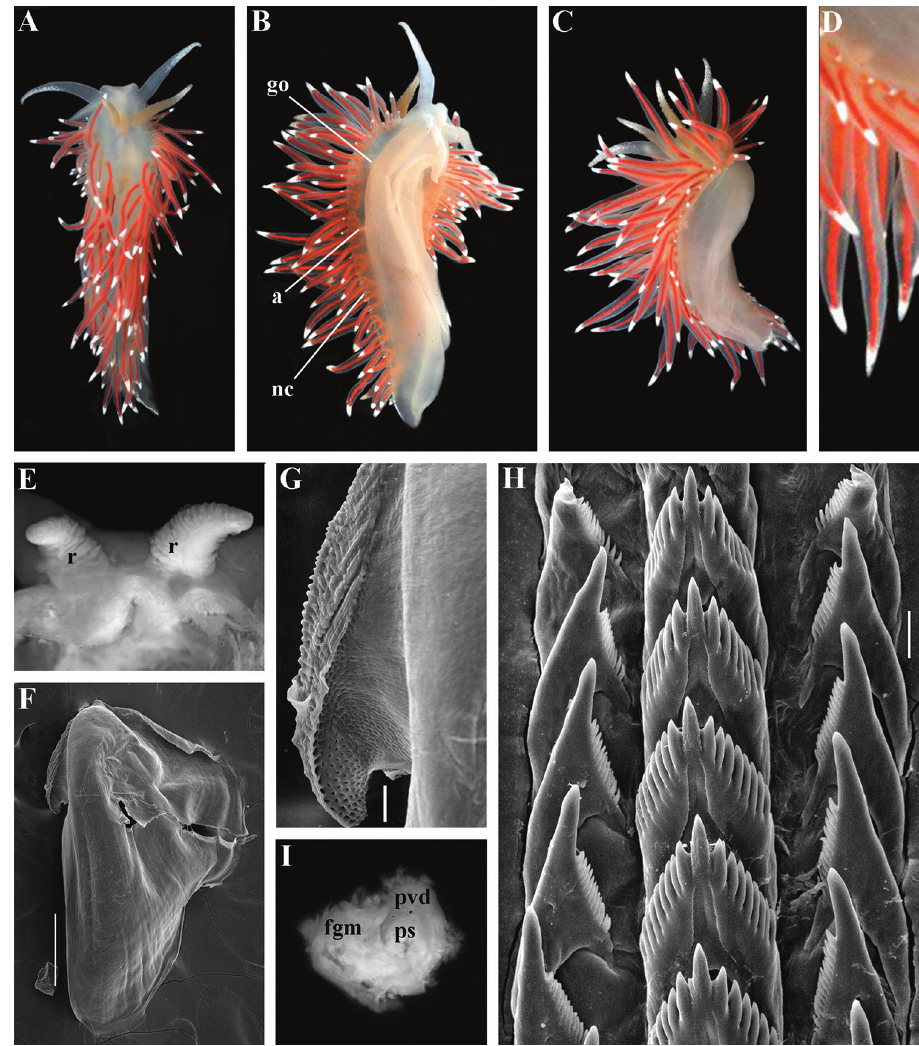
Figure 16. Borealia nobilis (Verrill, 1880), comb. n. ZMMU Op-510. White Sea, Cape Kartesh, 33 mm in length (live): A living animal, dorsal view B same, ventral view C same, lateral view D same, details of cerata E dissected anterior part (pharynx removed) and rhinophores, light microscopy F jaw, SEM G details of masticatory process of jaw, SEM H radular teeth, posterior part, SEM I reproductive system (non mature), light microscopy. Abbreviations: a anus fgm female gland mass go genital opening nc con- tinuous notal edge ps penial sheath pvd prostatic vas deferens r rhinophores. Scale bars: F = 300 μm; G, H = 30 μm. Photos and SEM images by T.A. Korshunova, A.V.